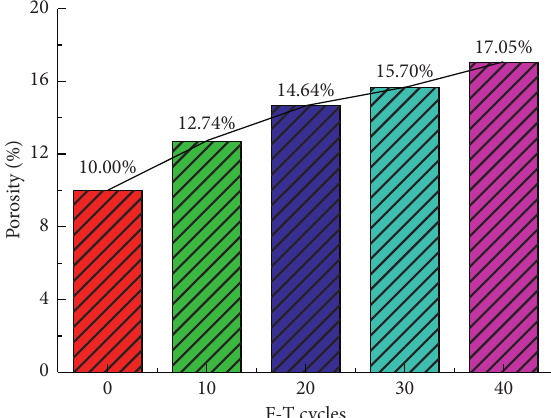
Figure 11: The trend of the average porosity varies with